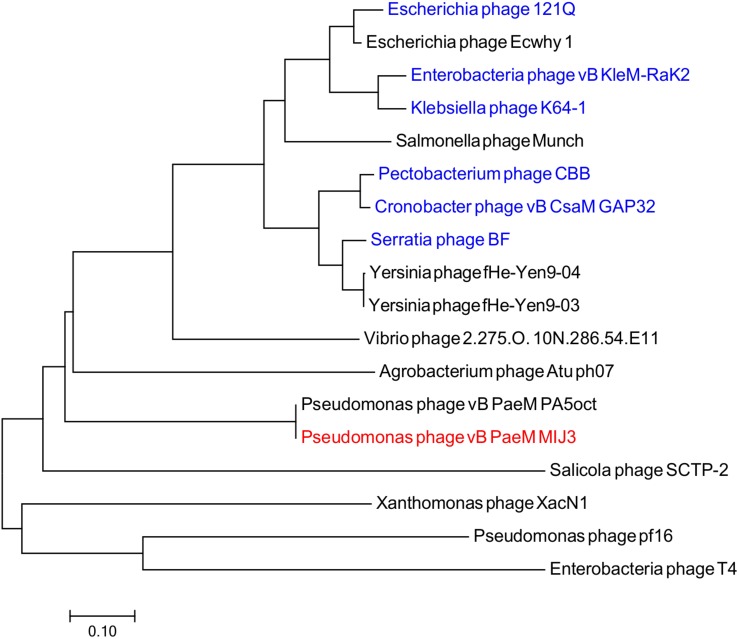
Phylogenetic tree comparing the terminase, large subunit of phage MIJ3 (red) with its corresponding in other jumbo phages, including Rak2-like phages (blue). Phages were selected as they share homology with the amino acid sequences of the terminase using Blastp. Phage T4 was selected as an outgroup phage that is not closely related to the corresponding sequence of MIJ3. The evolutionary history was inferred using the neighbor-joining method and the tree was constructed using MEGA7.